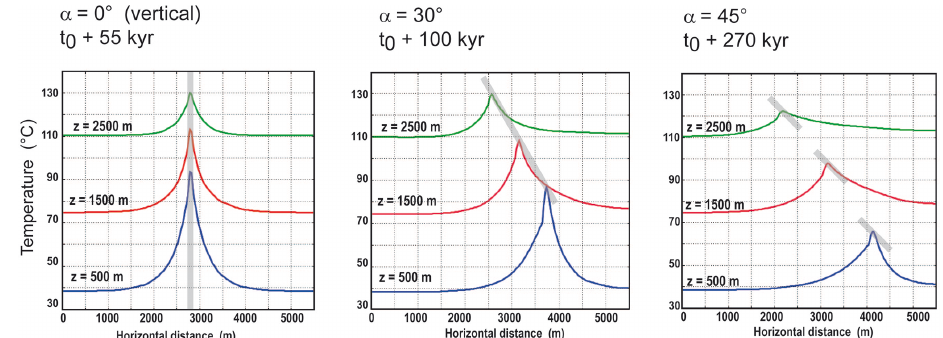
Figure 13. Effect of fault dip angle (angle is illustrated by grey rectangles) on horizontal profiles of temperature, perpendicular to the fault zone, at the time when the temperature anomaly is maximum (indicated on top of each case). While the lateral diffusion length remains similar ( ∼ 1200m on each side at a depth of 500m and ∼ 800–900m at a depth of 2500m), the amplitude is clearly greater in the vertical case ( ∼ 55 ◦ C at a depth of 500m in the vertical case and ∼ 28 ◦ C for a dip angle of 45 ◦